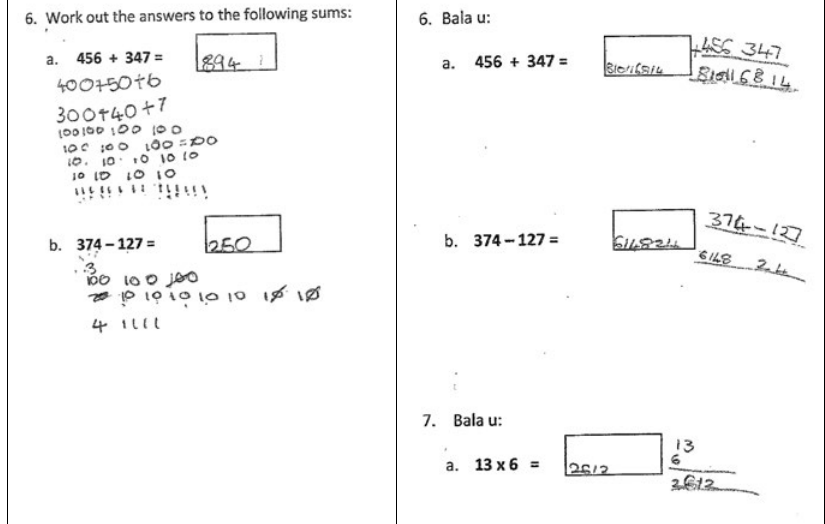
Figure 5: Extract 1 from grade 3 scripts, learners H and